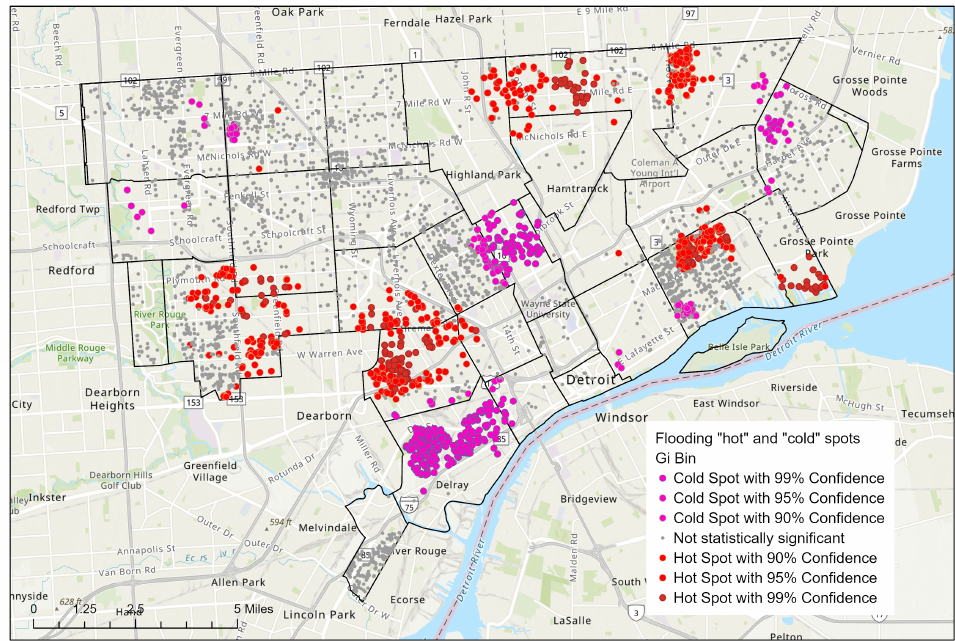
Figure 3. Hot and cold spots of flooding using the Getis-Ord Gi* statistic. Red dots represent “hot” spots, or locations of statistically significant clusters of homes that experienced flooding. Blue does represent clusters of homes that reported not experiencing